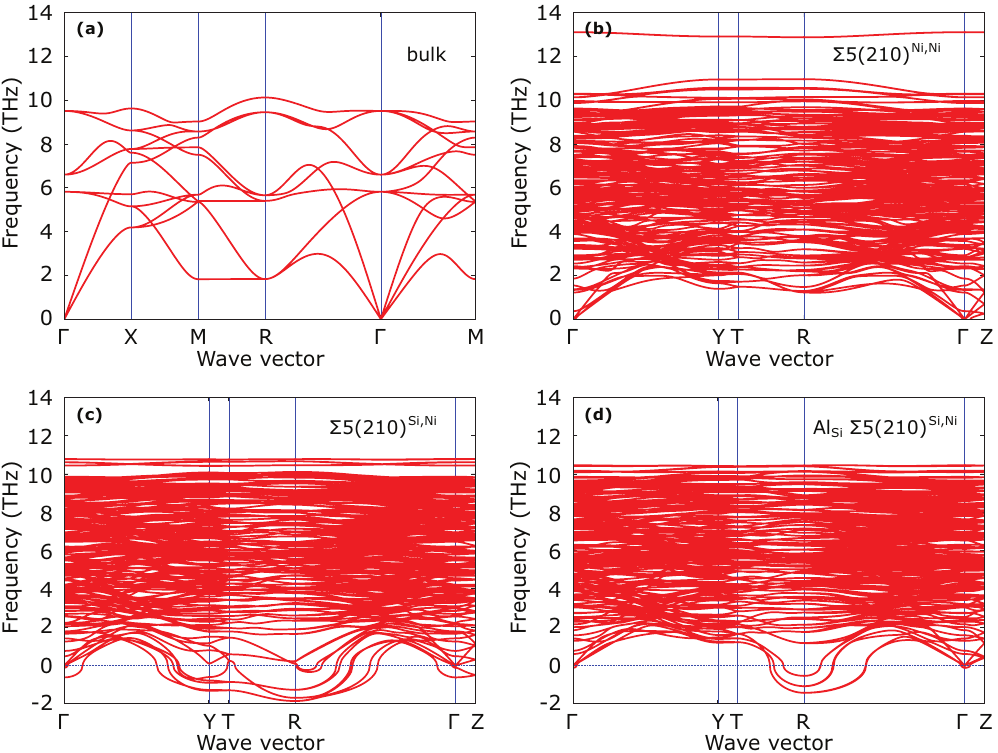
Figure A1. Phonon dispersion relations of ( a ) bulk Ni 3 Si, ( b ) stable Σ 5(210) Ni,Ni grain boundary, ( c ) unstable Σ 5(210) Si,Ni grain boundary and ( d ) Σ 5(210) Si,Ni grain boundary partially stabilized by substitution of Si at the GB plane by